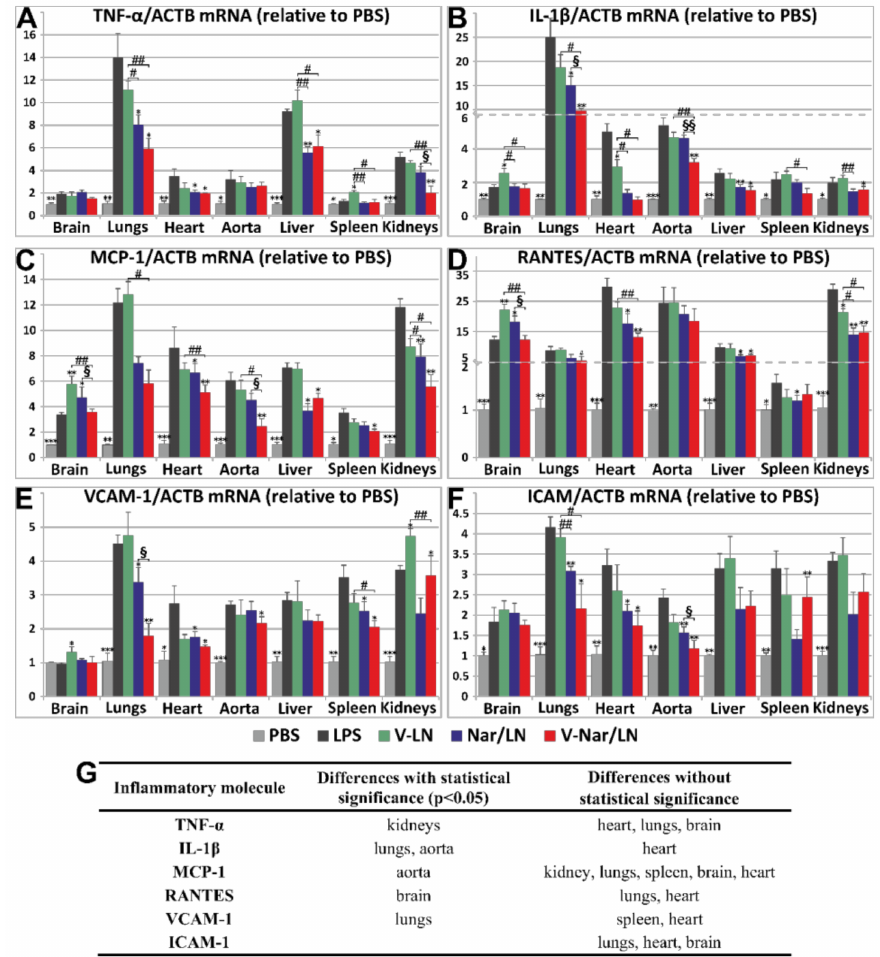
Figure 4. Gene expression of inflammatory markers ( A ) TNF- α , ( B ) IL-1 β , ( C ) MCP-1, ( D ) RANTES, ( E ) VCAM-1, and ( F ) ICAM-1 in organs harvested from C57 BL / 6 mice that were injected intravenously with non-targeted (Nar / LN) or VCAM-1 targeted (V-Nar / LN) naringenin-loaded nanoemulsions, administered retro-orbitally, in a murine model of LPS-induced inflammation. As controls, mice receiving PBS, LPS or VCAM-1 targeted empty nanoemulsions (V-LN) were used. Results were normalized to ACTB ( β -actin) and are expressed as fold changes compared with the PBS-treated mice, considered as 1. The data are expressed as mean ± SD. Statistical significances: *, versus LPS; #, versus V-LN; §, versus Nar / LN; * p < 0.05, ** p < 0.01, *** p < 0.001; # p < 0.05, ## p < 0.01; § p < 0.05, §§ p < 0.01. There were 3 animals per group, except Nar / LN which consisted of 4 animals. ( G ) Summary of statistically significant reductions of the expression of LPS-induced inflammatory mediators, in di ff erent organs, by V-Nar / LN as compared to Nar /